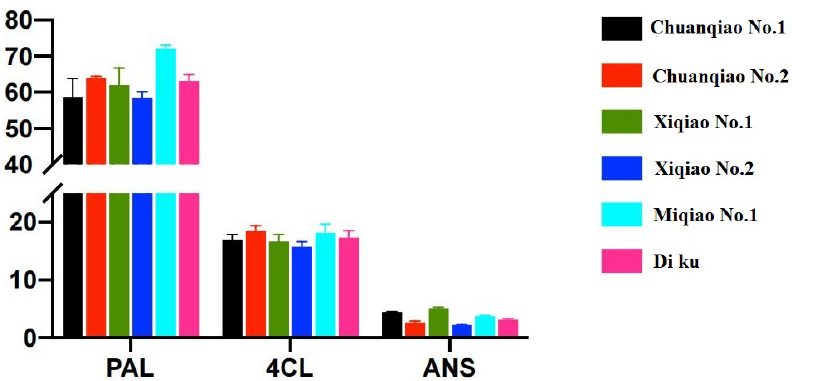
Figure 5. Expression analysis of key enzyme genes in different varieties of Tartary buckwheat. Note: There was no significant difference in the expression of three genes in different varieties of Tartary buckwheat ( p > 0.05).